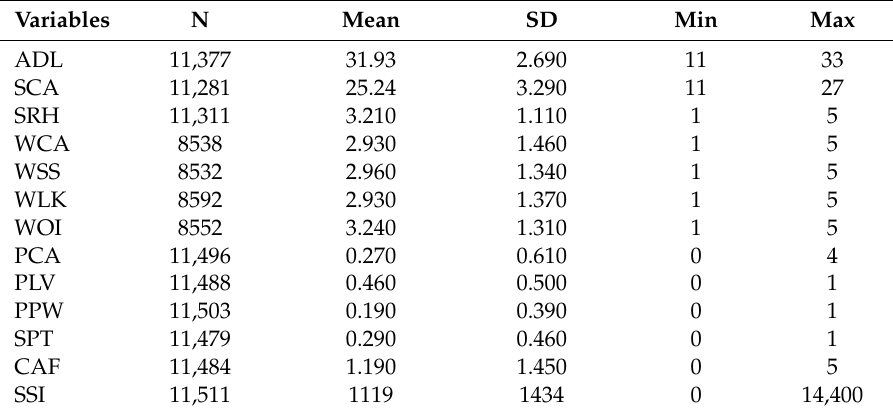
Table 3. Descriptive statistical results of indicator